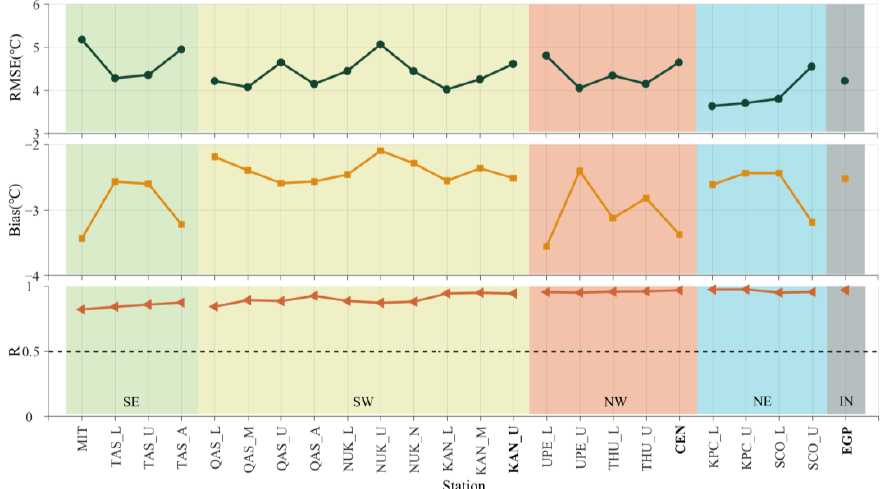
Figure 3. Correlation coefficient (R), bias, and root mean squared error (RMSE) between daily MODIS IST and observations from all AWSs (AWSs shown in bold are above the ELA).